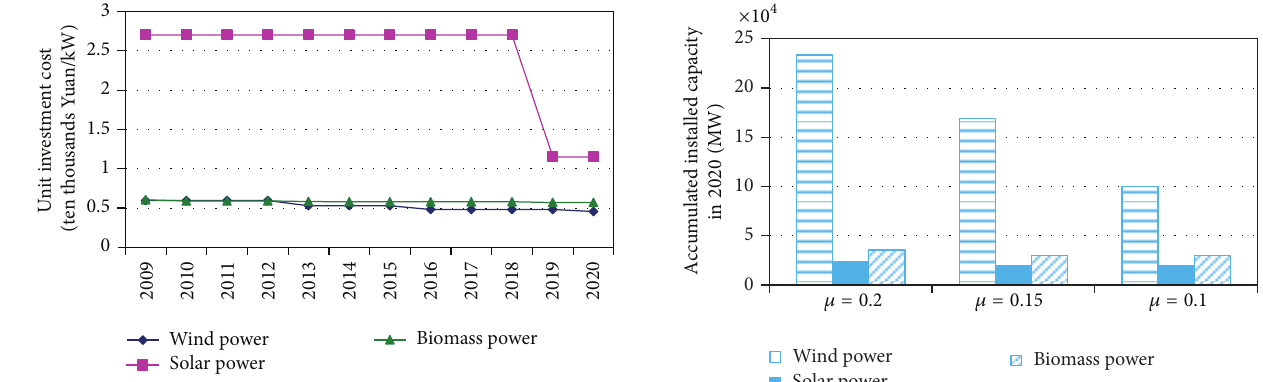
Figure 6: The impact of 𝜇 on the accumulated installed capacities of renewable power in